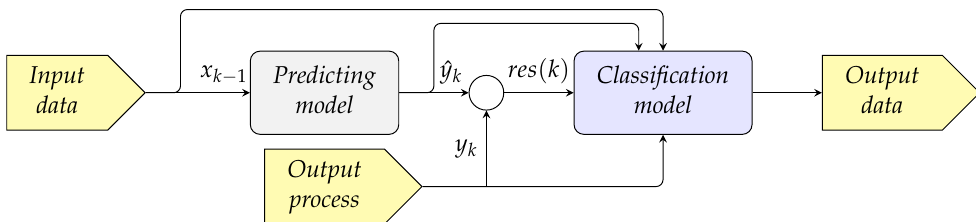
Figure 2. General architecture model to detect and isolate cyber attack. As the characteristics of the signals in a specific process are different then values with different magnitude could affect the classifier training procedure, therefore, all input data to the classifier are normalized using its mean and standard deviation to obtain a z-score for each one as is shown in